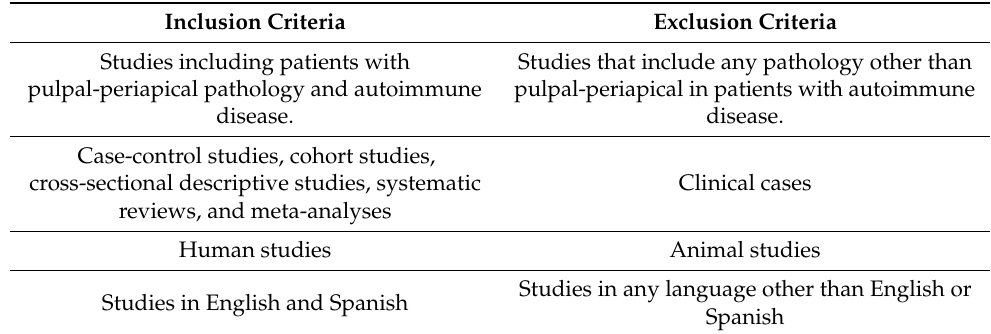
Table 2. Inclusion and exclusion